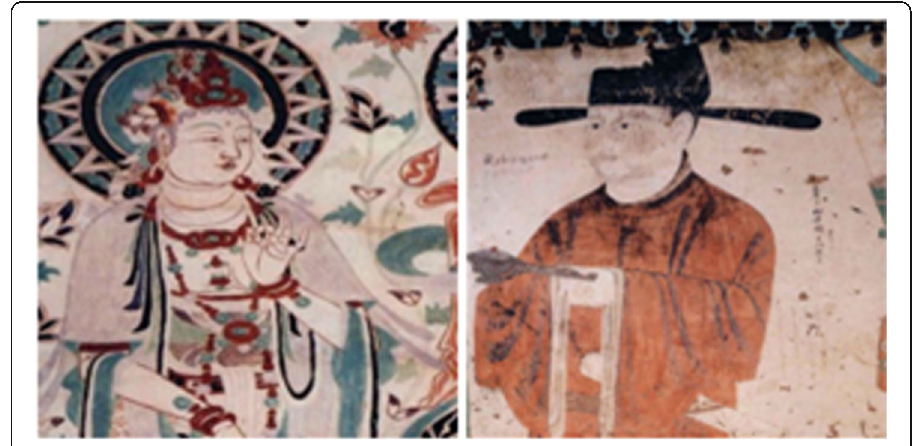
Fig. 18 Mural images of the Song/Jin